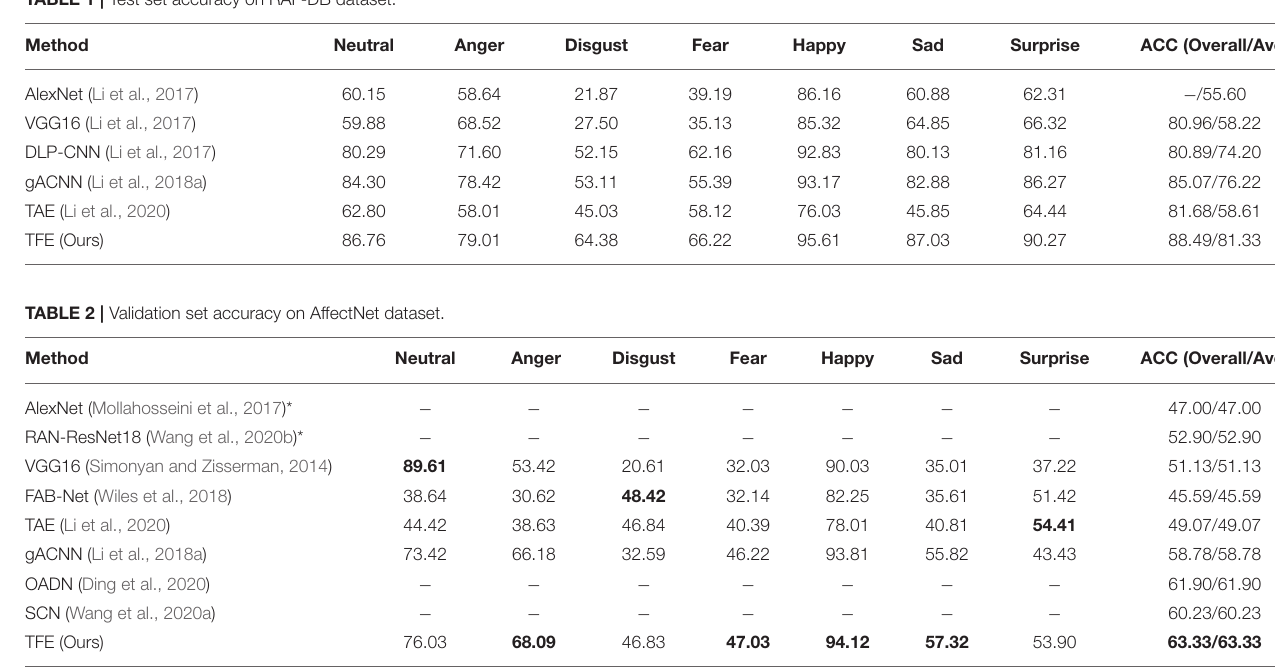
TABLE 1 | Test set accuracy on RAF-DB dataset.